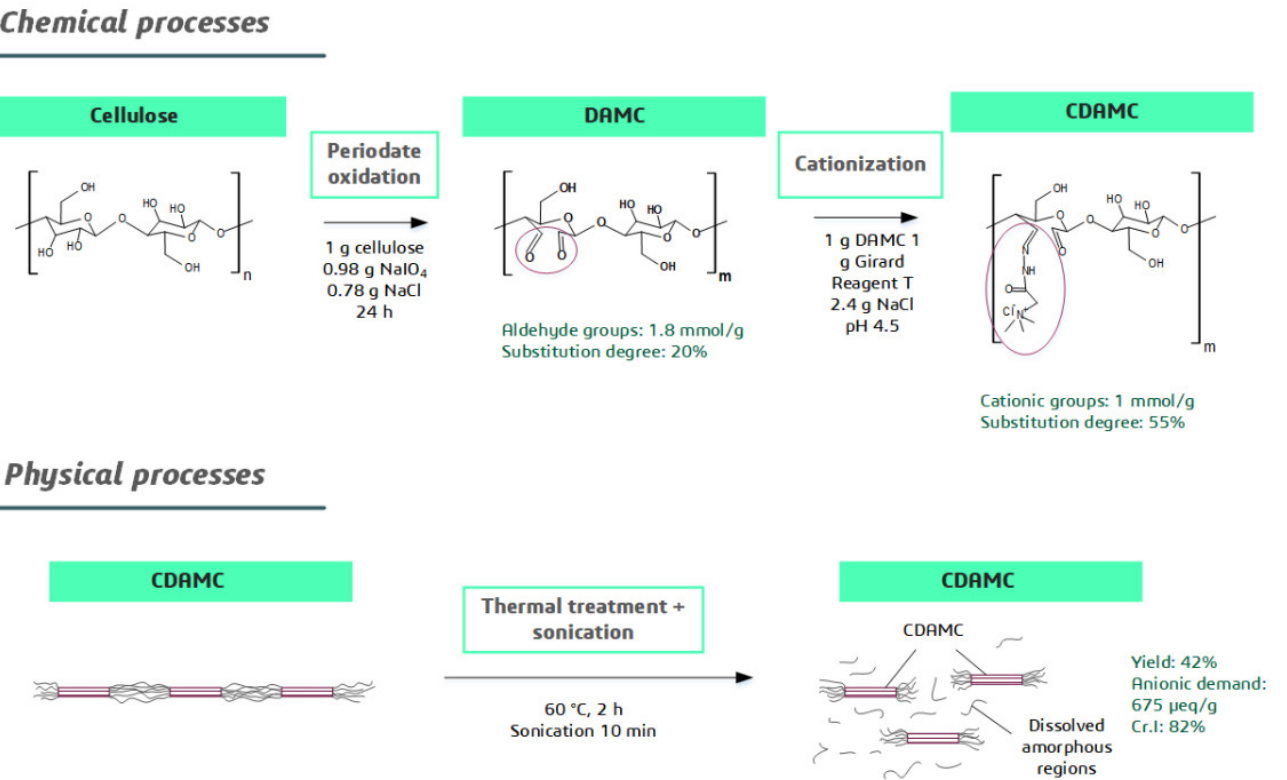
Figure 1. Graphical scheme of CCNC synthesis steps.